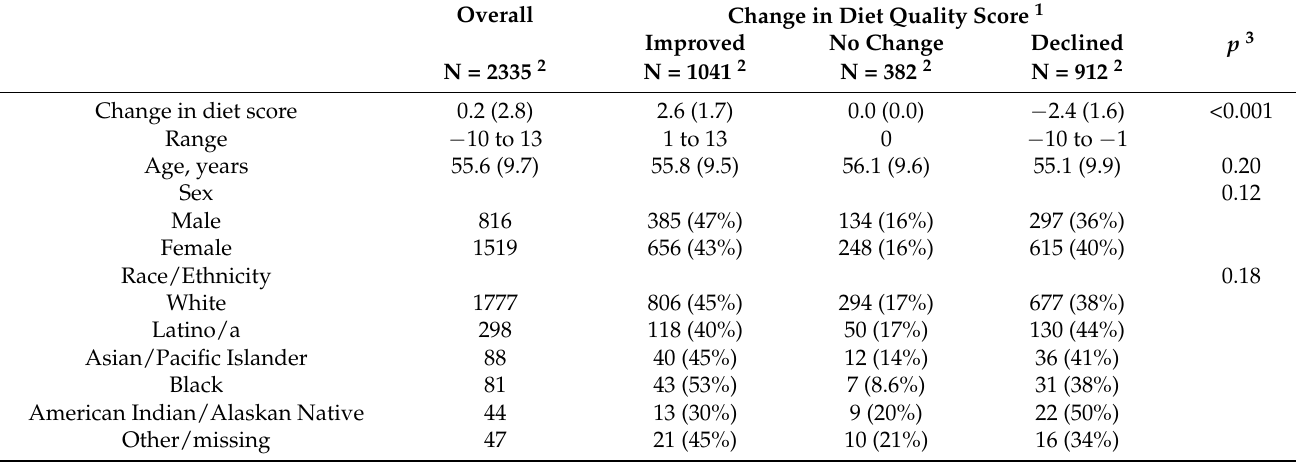
Table 1. Characteristics of Cancer Prevention Study-3 participants who completed an online